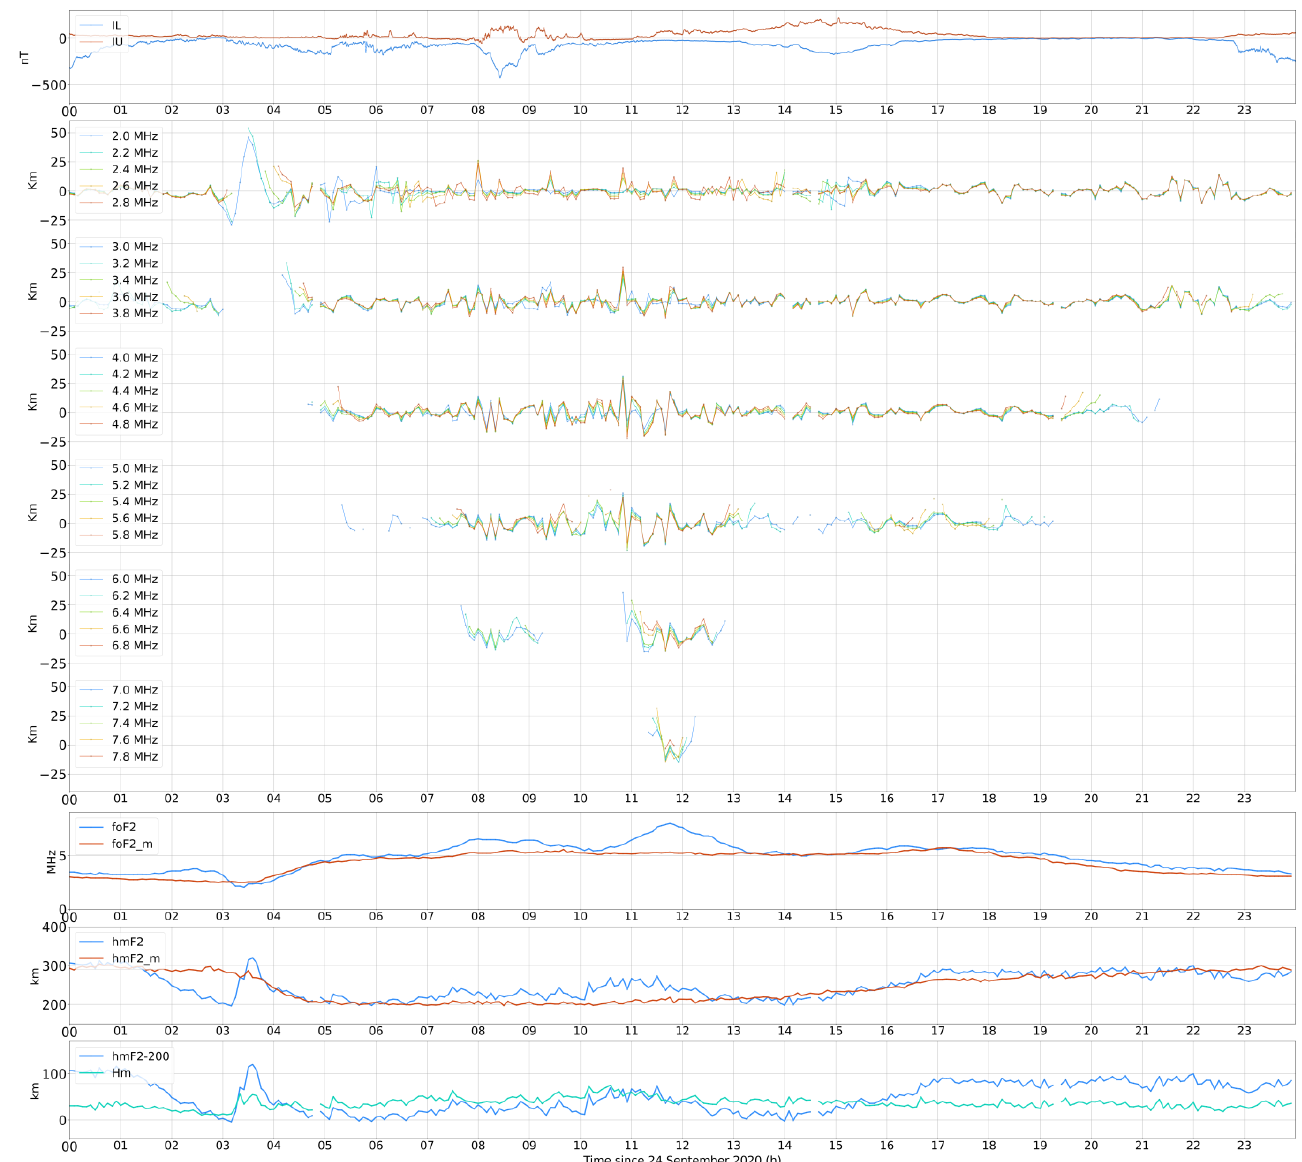
Figure 2. The IU and IL auroral electrojet indicators, together with the detrended height of iso-ionic densities and the variability of the ionospheric characteristics at the height of peak density, during